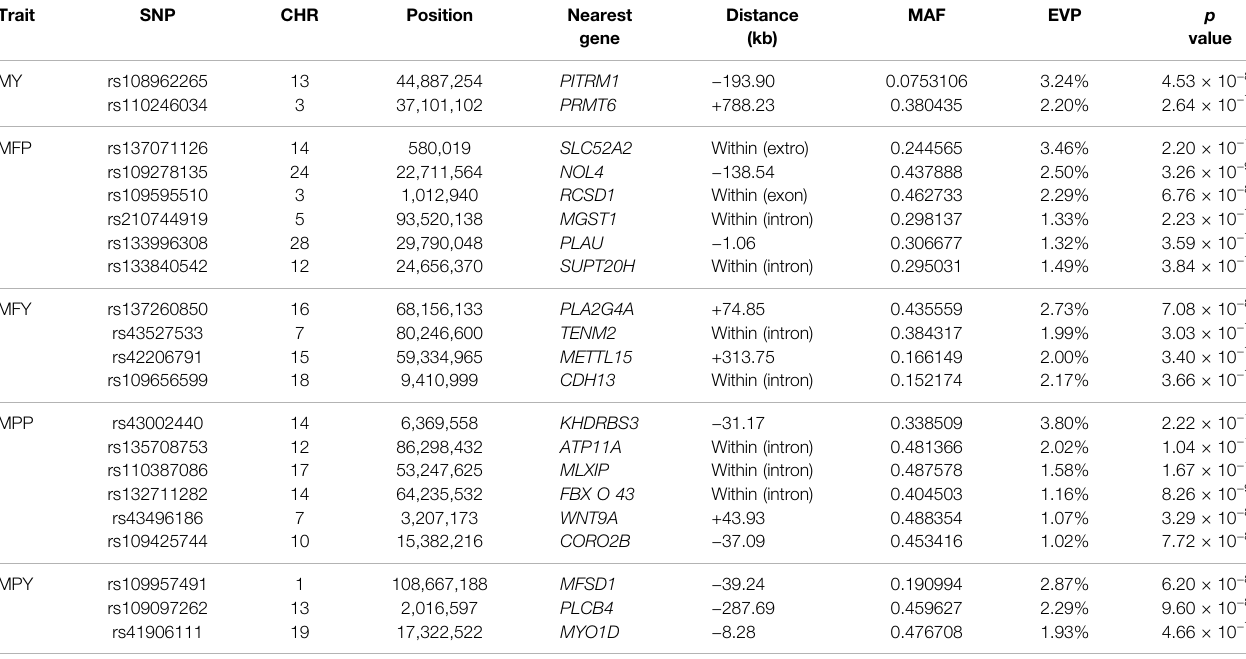
TABLE 2 | Information of the identi fi ed 21 variants in the association analysis. Trait